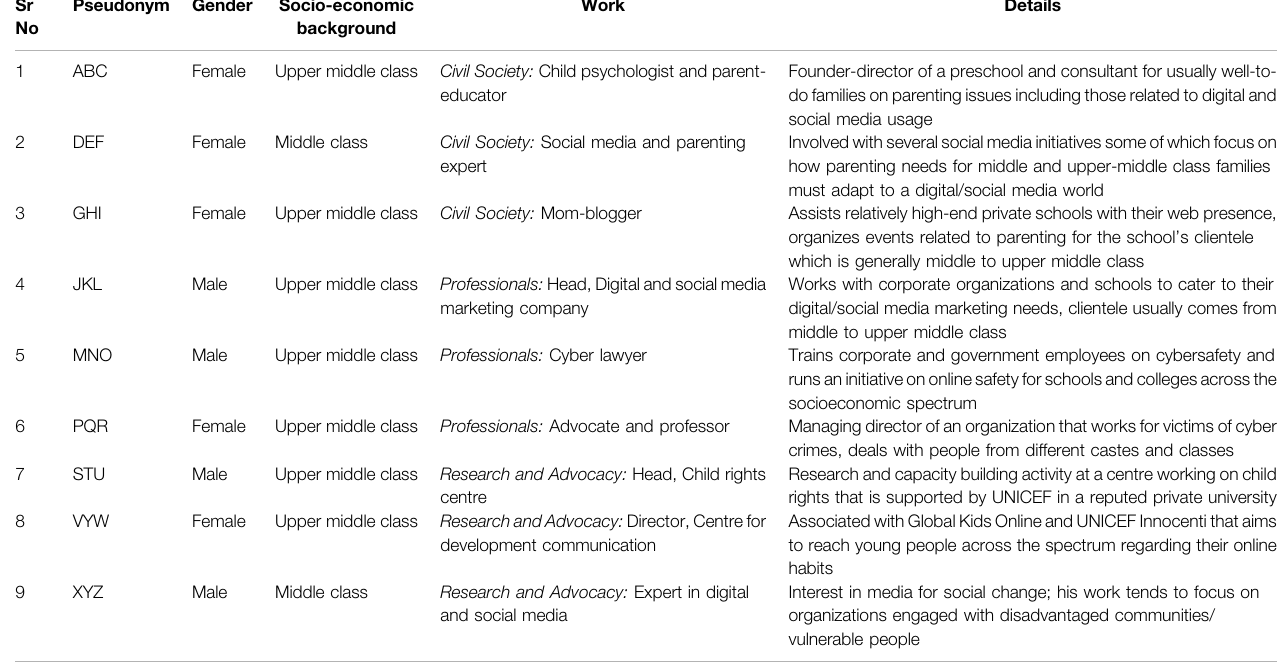
TABLE 1 | Details about the participants.